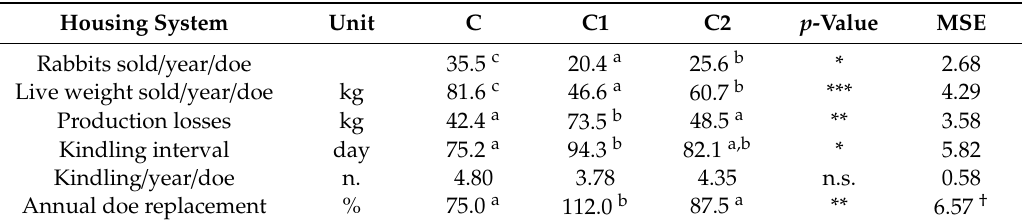
Table 5. E ff ect of housing system on indexes of global